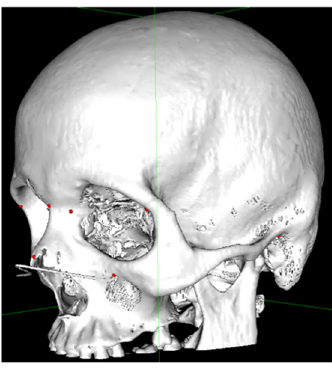
Figure 3. A 3D model with the marked points showed as red dots.